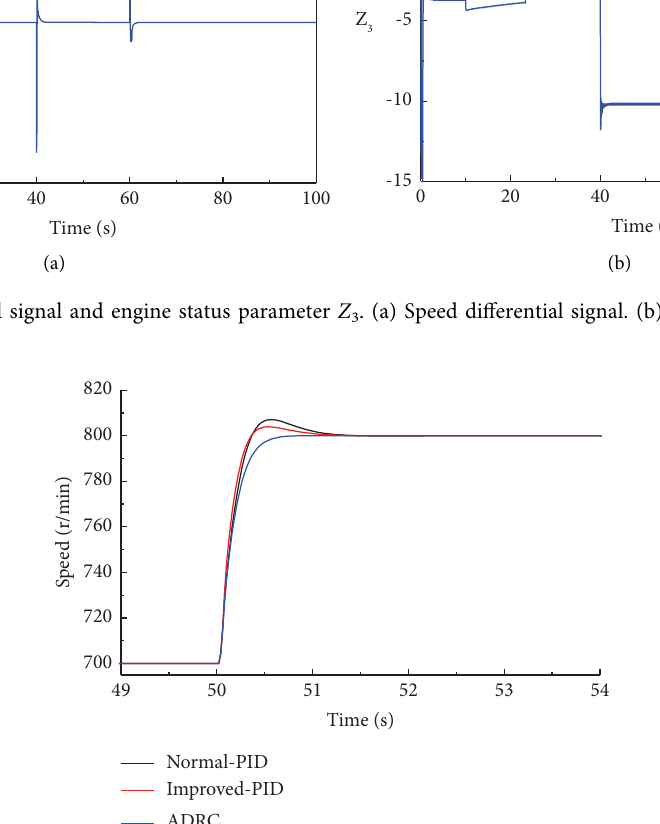
Figure 17: Target speed sudden increasing results with diferent control